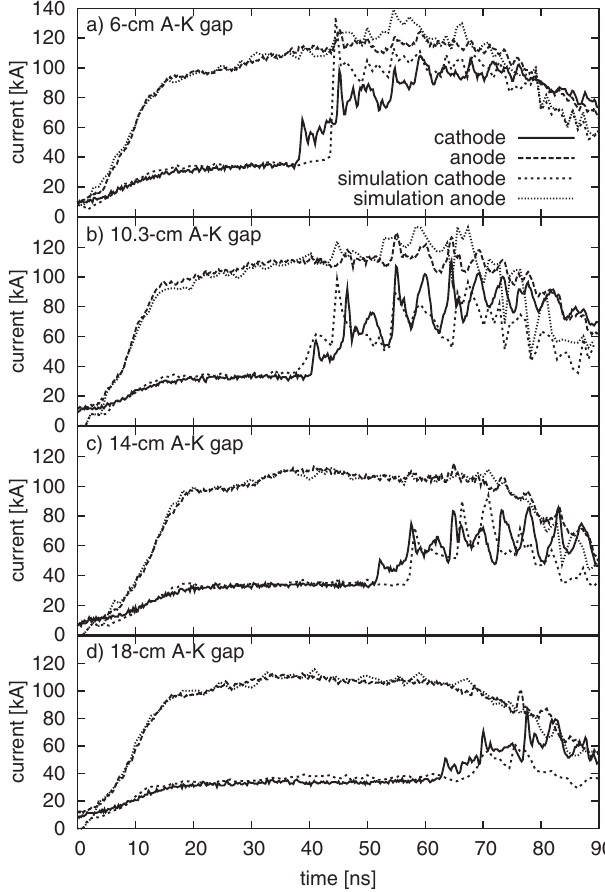
FIG. 10. Simulation results compared to data for the dustbin/ knob configuration with large-area-diode loads with A-K gaps of 6, 10.3, 14, and 18 cm (RITS-6 shots 63, 58, 67, and 57, respectively). Currents were measured at position F in Fig. 2. The retrapping wave arrives at (cid:1) 38 ns in (a), (cid:1) 41 ns in (b), (cid:1) 52 ns in (c), and (cid:1) 63 ns in (d).